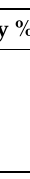
Table 13. Performance of the deep motion model based on DMMs and MDMMs concatenated with spatial information in terms of MSR daily activity 3D